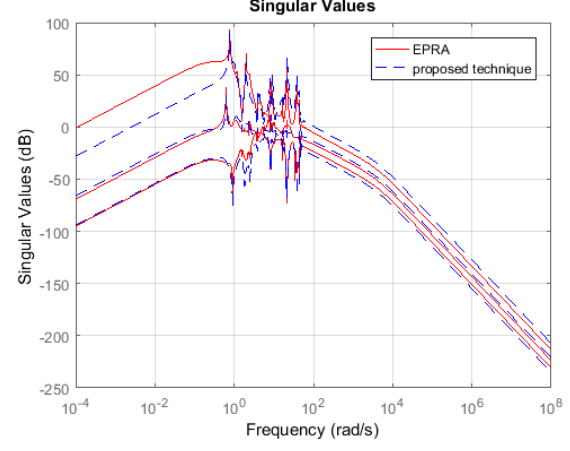
Figure 8. Sigma plot of K ( s ) P ( s ) .